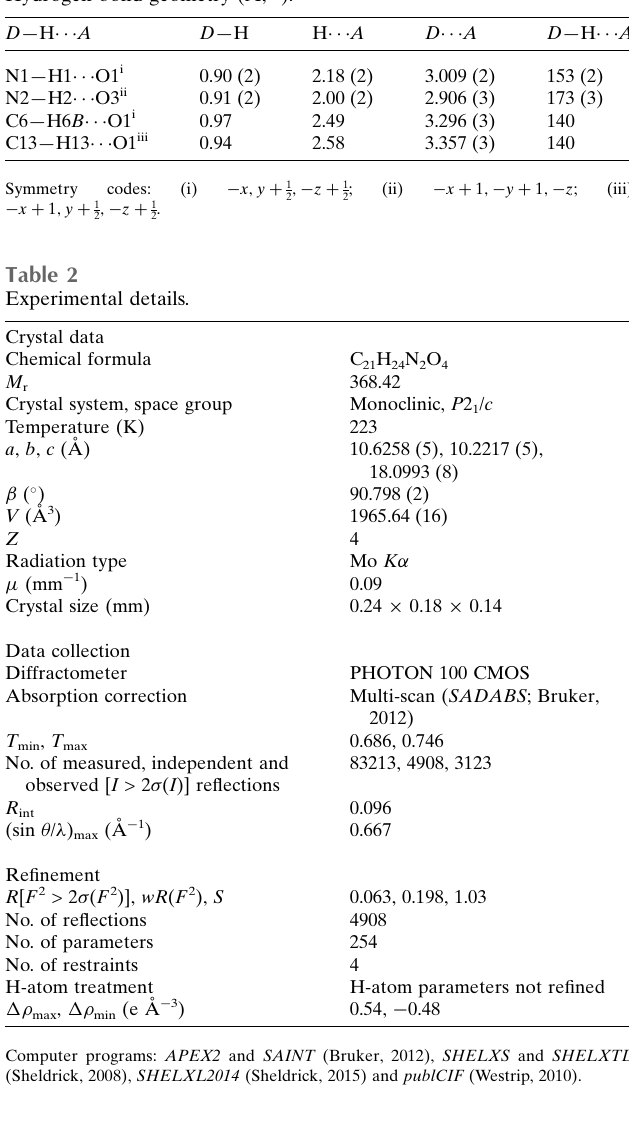
Table 1 Hydrogen-bond geometry (A˚ , (cid:2) ).